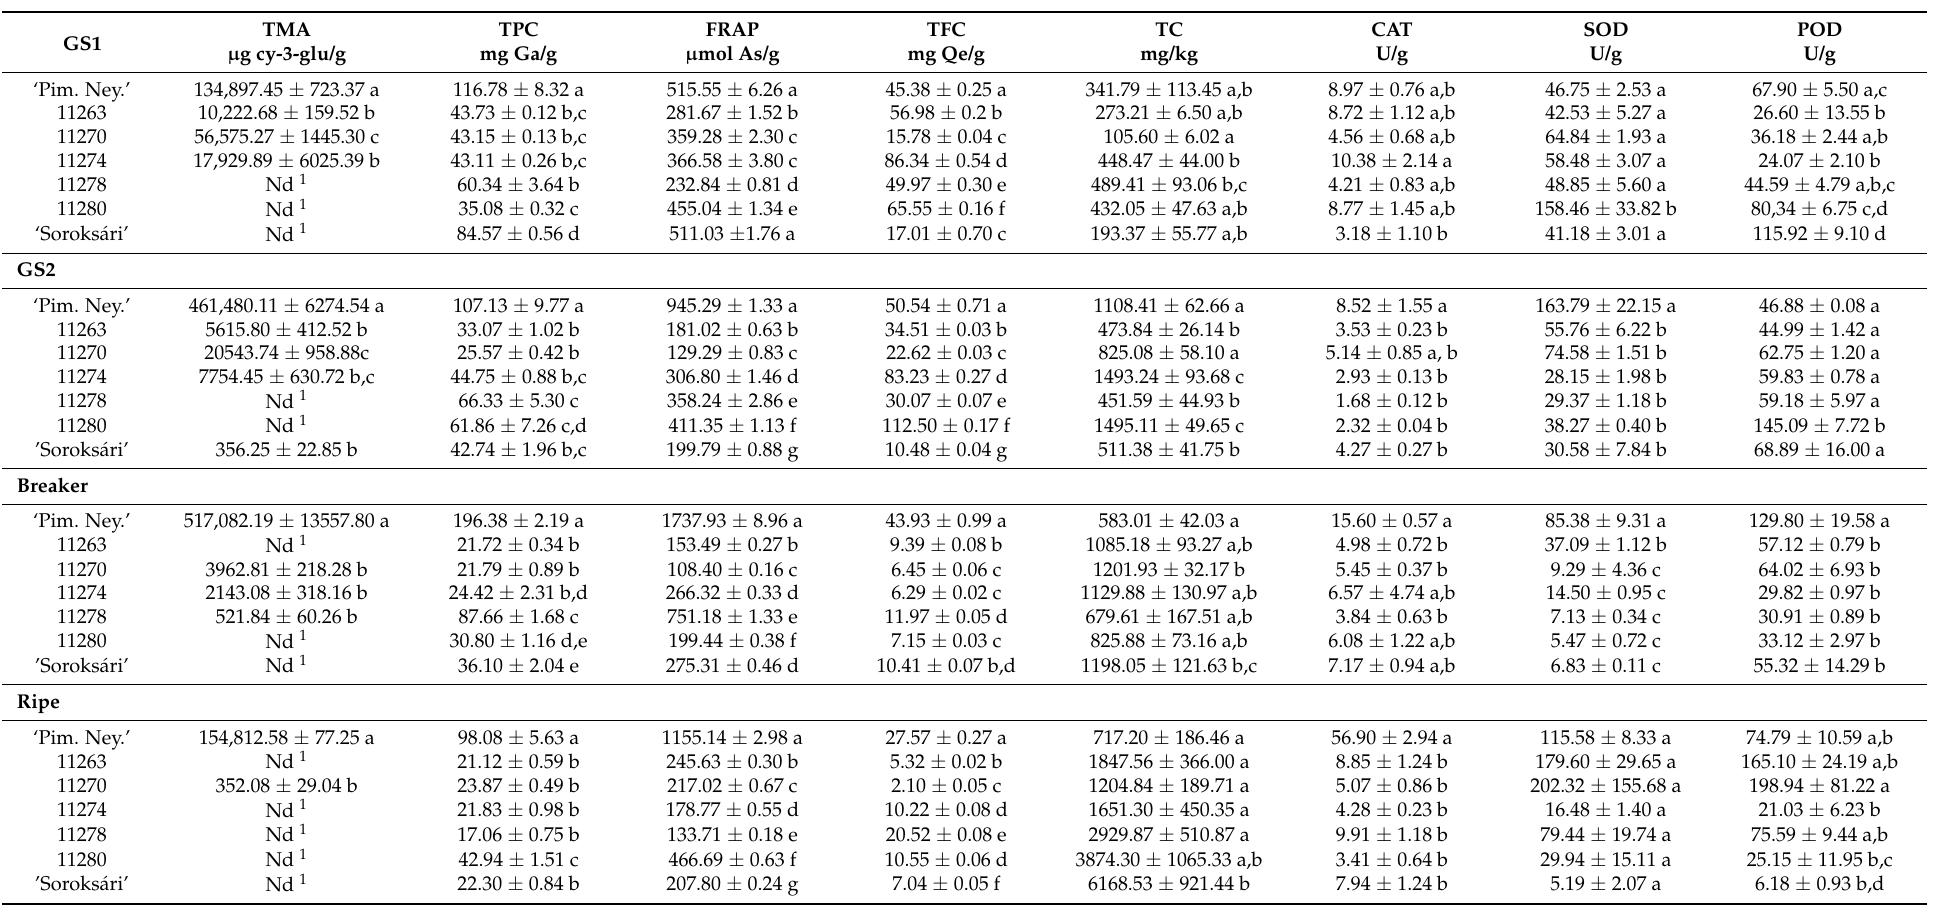
Table 3. Means and standard deviation of the means of the enzymatic activity and phytochemicals measured in different phenophases (in